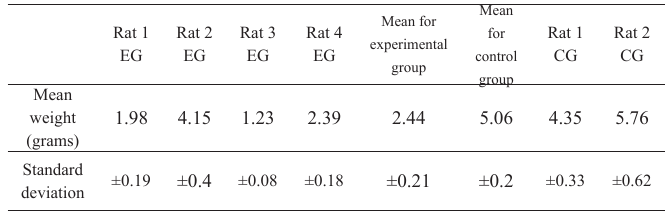
TABLE 1 – Description of the mean weights of the newborns in the experimental and control groups, in